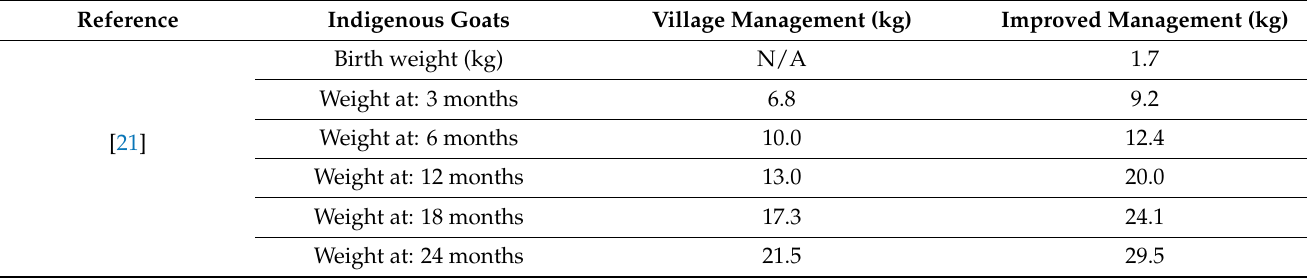
Table 1. Performance of indigenous goats raised in the village and improved management systems [21].